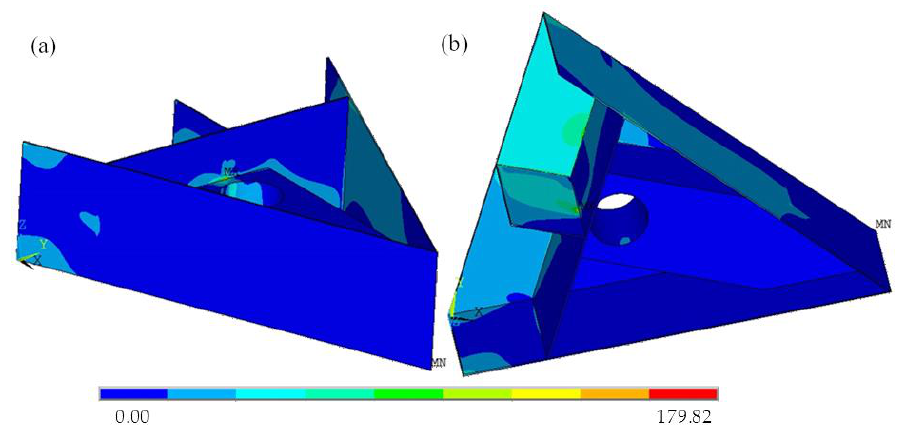
Figure 11. Distribution of the von Mises stress (in MPa) for the triangular shape of the superior bracket under ULS conditions: ( a ) superior view and ( b ) inferior view.